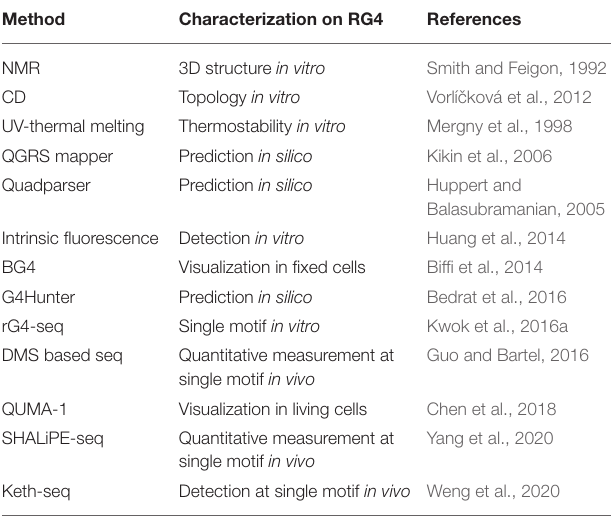
TABLE 1 | Methods to study